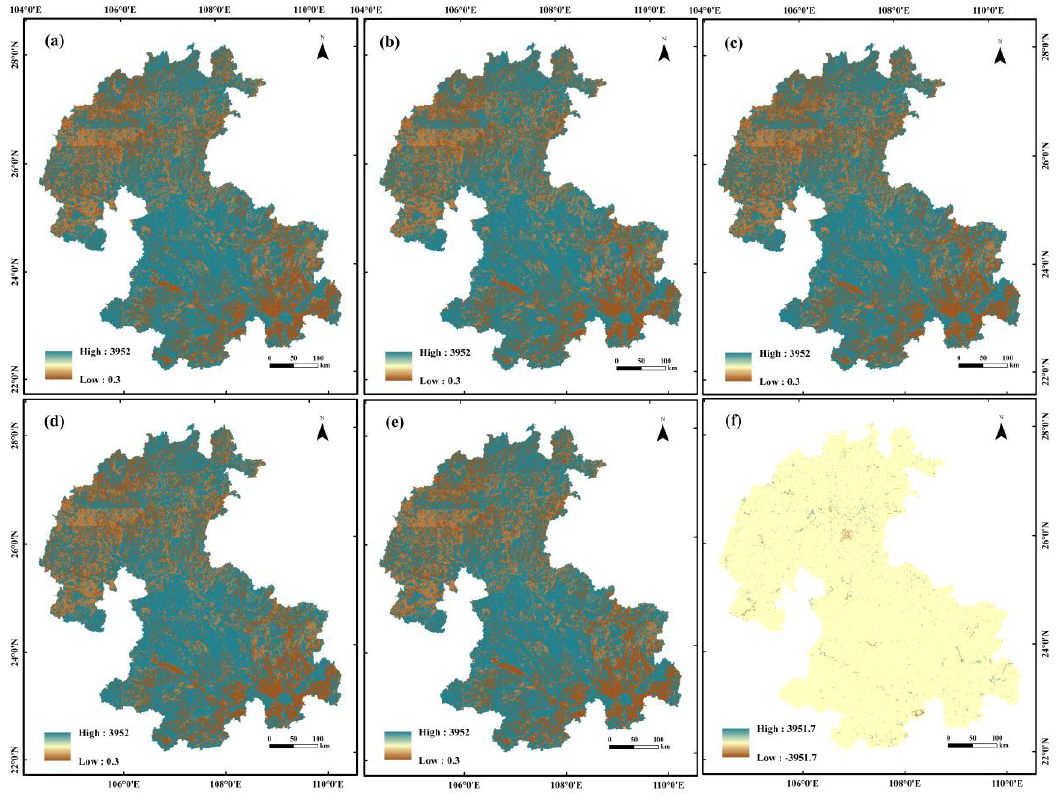
Figure 6. Carbon storage from 1990 to 2010, ( a ) 1990, ( b ) 1995, ( c ) 2000, ( d ) 2005, and ( e ) 2010, and ( f ) carbon storage variations from 1990 to 2010 (all units are in t/km 2 ).